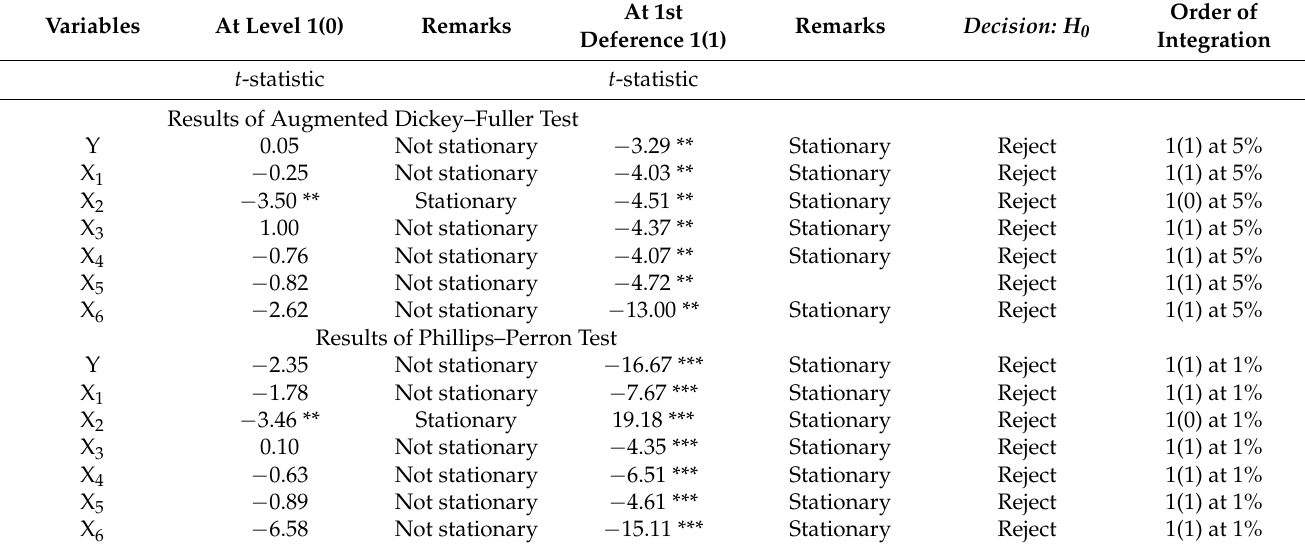
Table 1. Results of the Stationarity/Unit Root